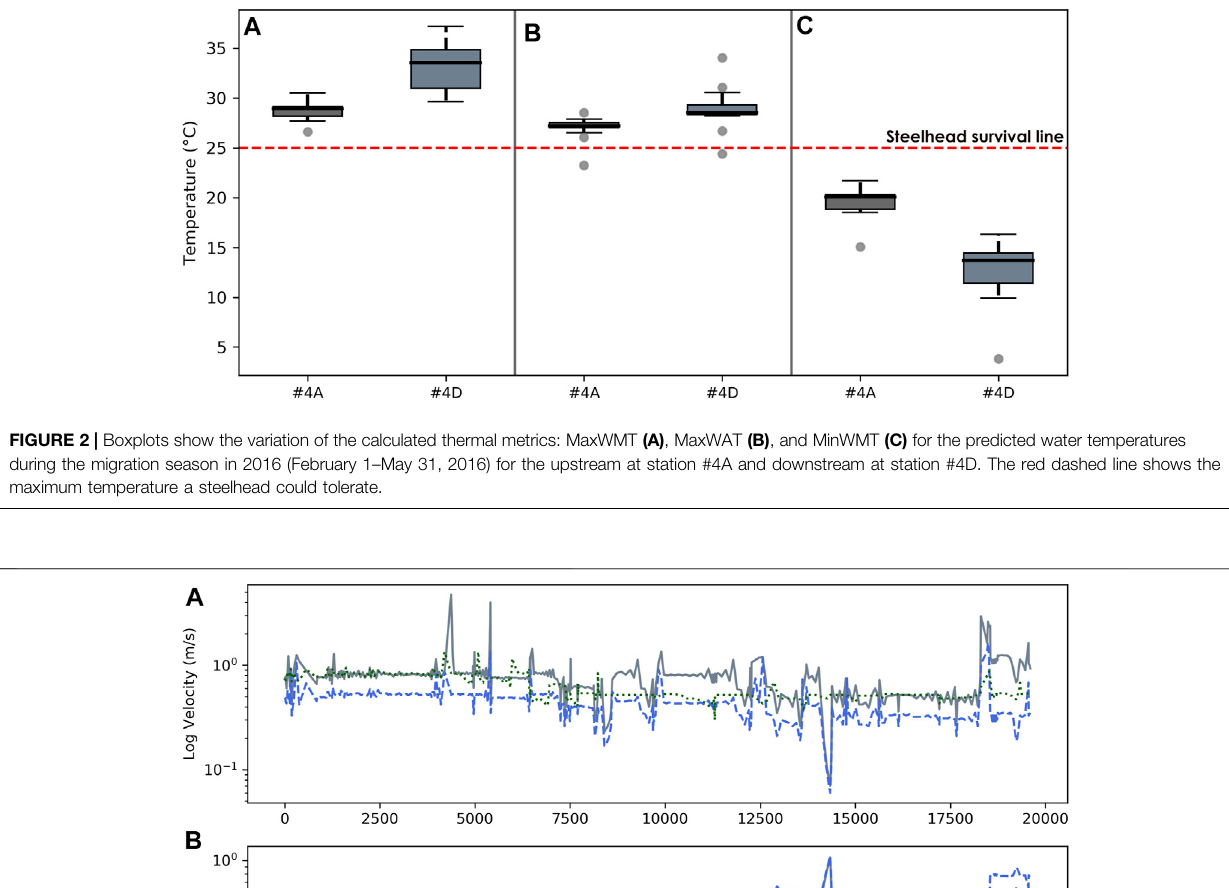
Frontiers in Environmental Science |